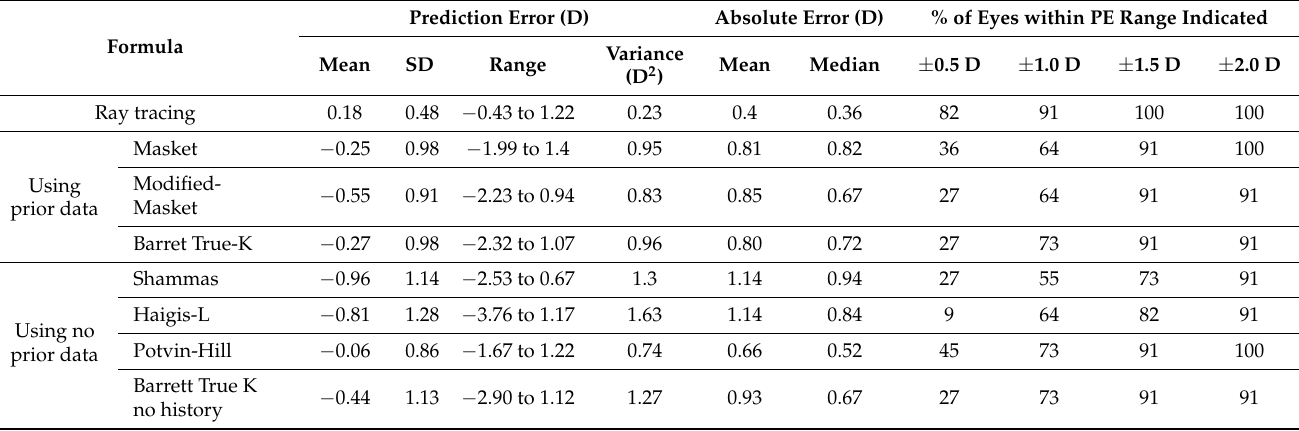
Table 3. Formula performance in